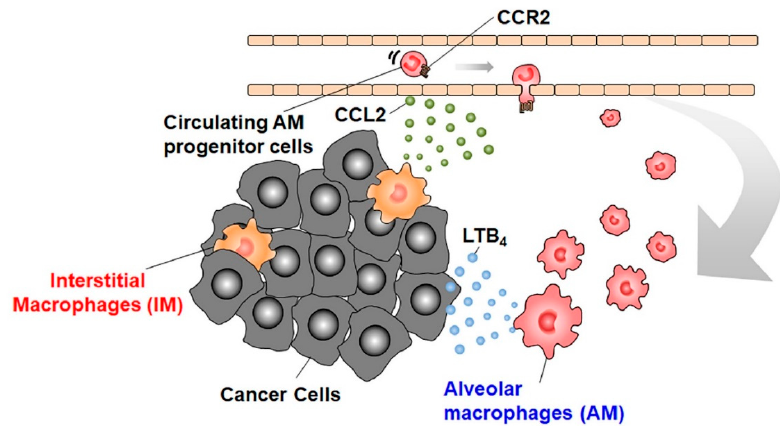
Figure 4. Interplay between IMs and AMs in lung metastasis. AMs are recruited from blood circulation, under the guidance of IM-derived CCL2 into metastatic lungs and contribute to the progression of lung metastasis by providing LTB 4 .